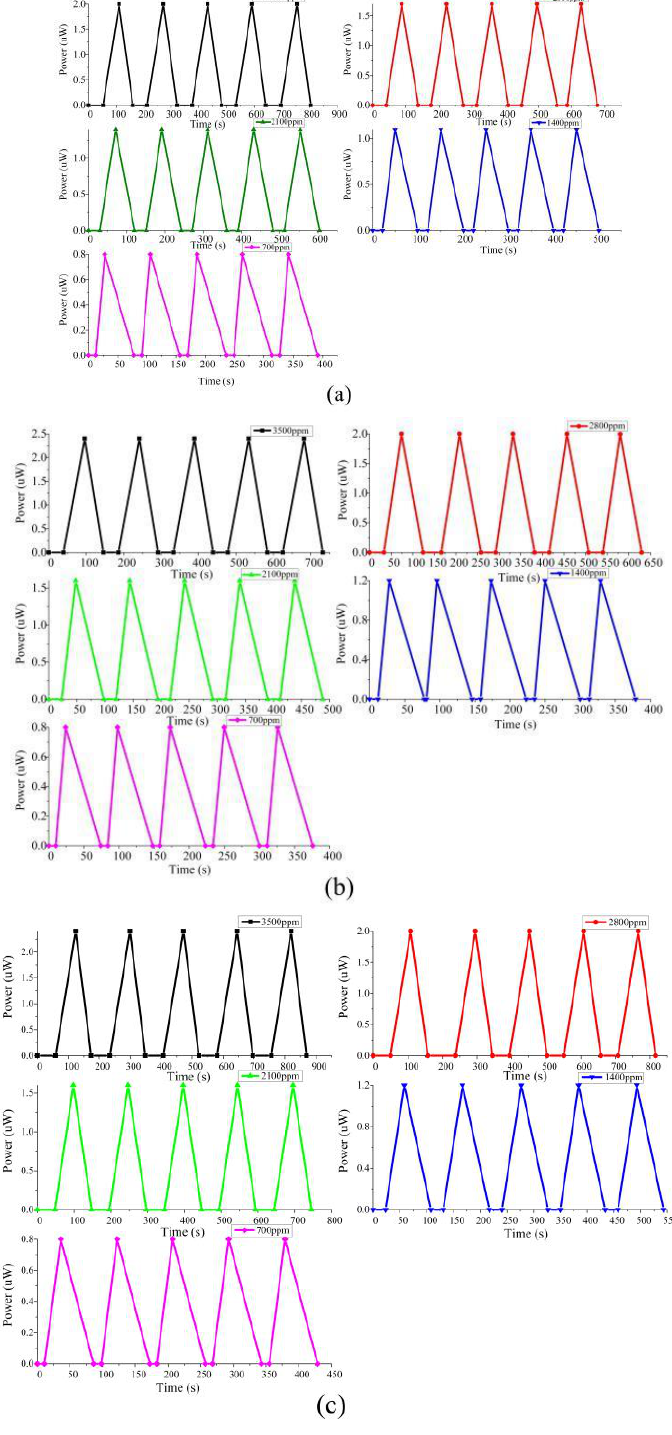
Figure 7. The repeatability results of ( a ) POF-PPy1, ( b ) POF-PPy2, and ( c ) POF-PPy3.